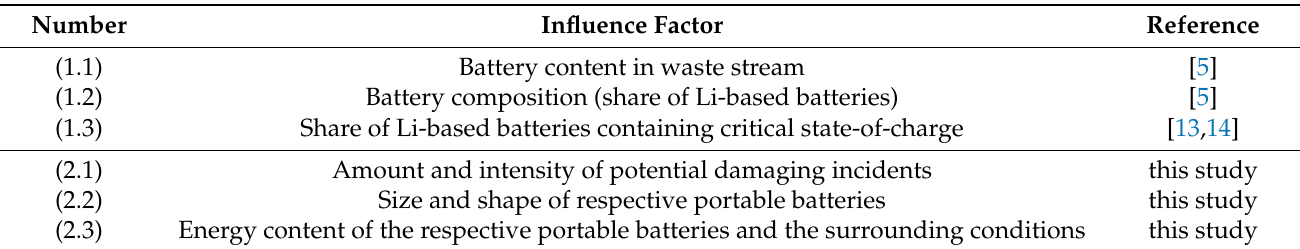
Table 3. Overview of the relevant influence factors on the presence of a fire-hazardous battery (1.1–1.3) and on critical damage to the present battery (2.1–2.3).